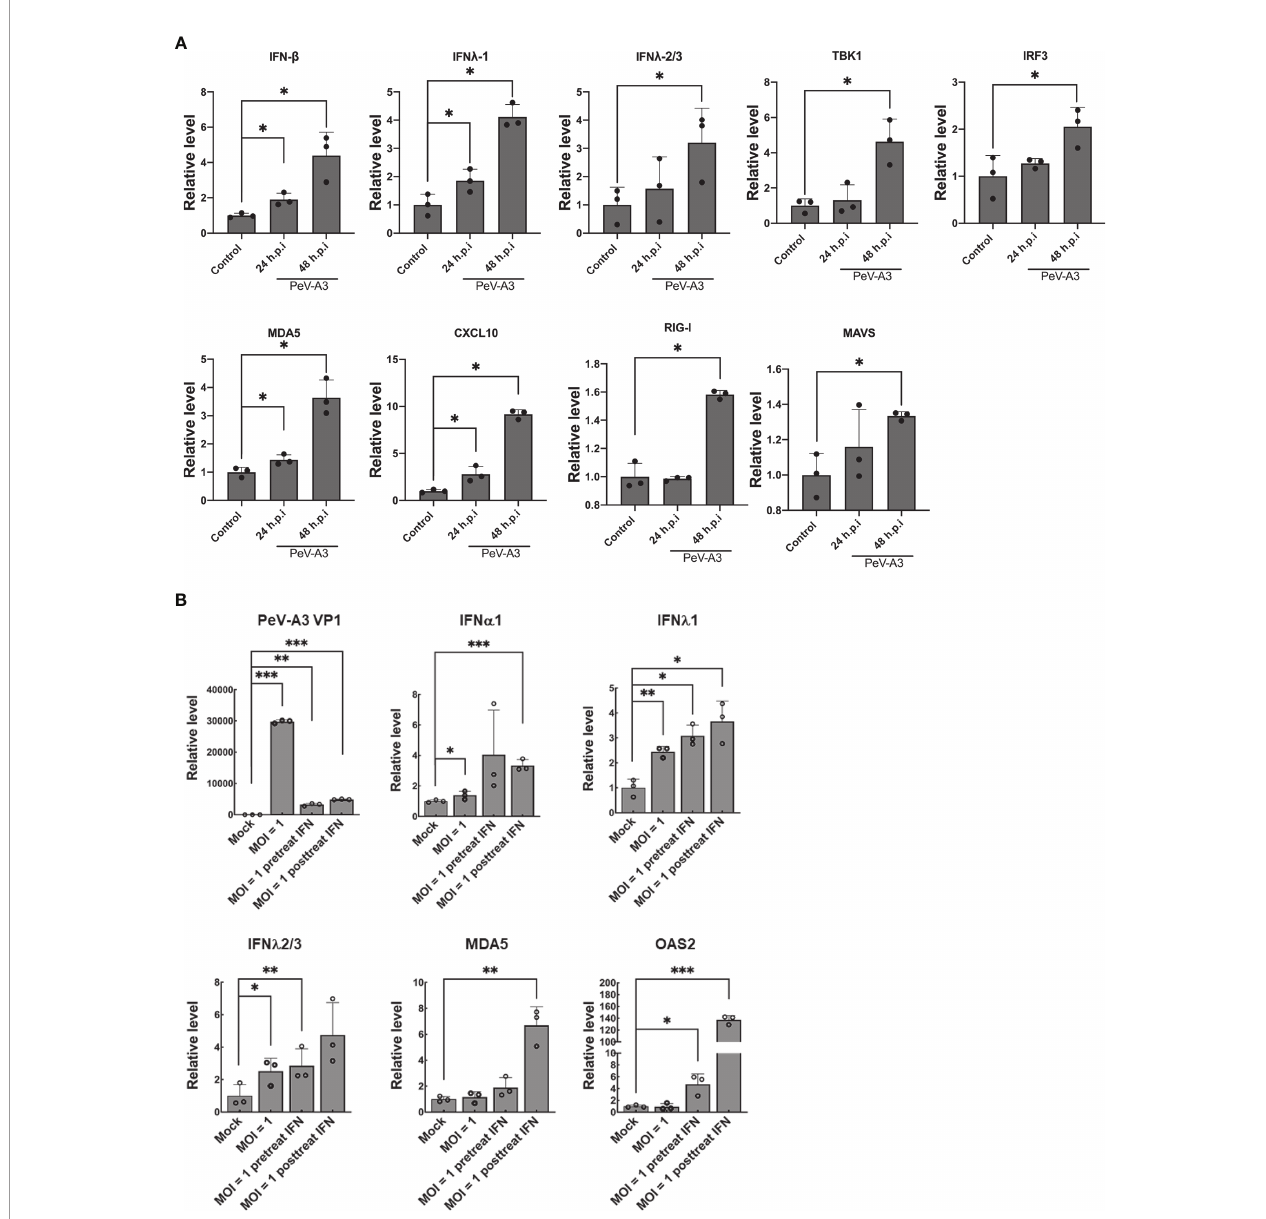
FIGURE 2 | PeV-A3 infection activated cellular antiviral innate immunity. (A) GBM cells were infected with PeV-A3 at MOI = 1 for 24 and 48 h. mRNA levels of antiviral genes IFN b , IFN l 1, IFN l 2/3, TBK1, IRF3, MDA5, CXCL10, RIG-I, and MAVS were con fi rmed using RT-qPCR. The level of transcripts was normalized by GAPDH. Data are mean ± SD of three independent experimental samples. Student ’ s t-test, * p < 0.05 compared with mock controls. (B) Ef fi cacy of type I IFN against PeV-A3. IFN- a 2 measuring 100 IU/ml was pretreated or posttreated in GBM cells for 24 h. GBM cells were infected with PeV-A3 at MOI = 1 for 24 h. Expression of mRNA of IFN a 1, IFN l 1, IFN l 2/3, MDA5, and OAS2 was measured using RT-qPCR and normalized to GAPDH. Data are mean ± SD of three independent samples. Student ’ s t-test, * p < 0.05; ** p < 0.01, *** p < 0.001 compared with mock controls. PeV-A3, parechovirus type 3; GBM, glioblastoma; MOI, multiplicity of